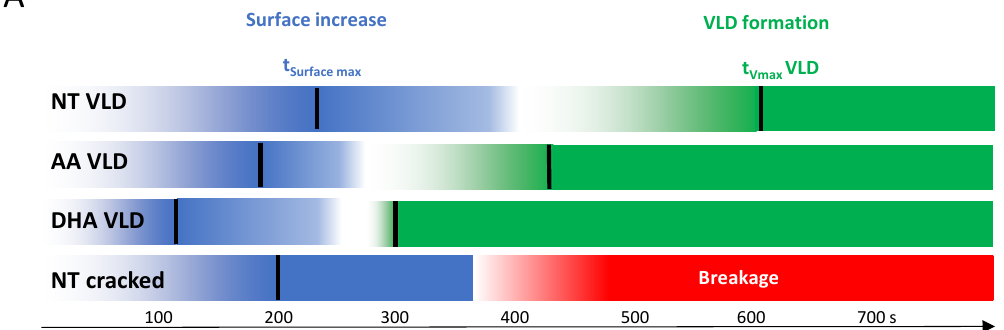
and fluorescence (543 nm) images (right) of FM1-43-labeled myoblasts before (above) and after (below) osmotic downshock. White arrows designate two cell breakages (for dynamic view, see Movie S2). Scale Bar: 20 µ m. ( B ) Composite image of fluorescence images recorded at 515 and 543 nm showing both VLDs and cells with high yellow fluorescence. Scale Bar: 20 µ m. ( C ) Relative fluorescence intensity at 543 nm obtained at the end of the osmotic downshock. The % displayed indicate